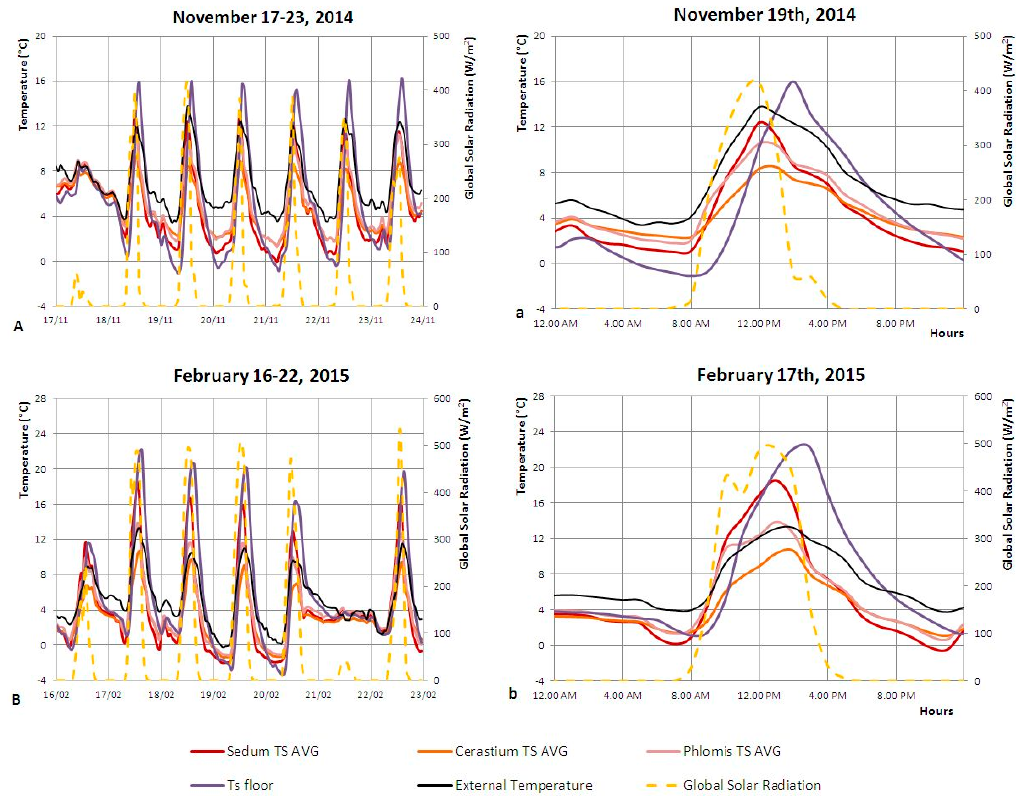
Figure 9. Ts analysis as a function of the global solar radiation and the external temperature: ( A , a ) autumn 2014; ( B , b ) winter 2014–2015. Upper case letters refer to the reference week, while lower case letters refer to the reference day